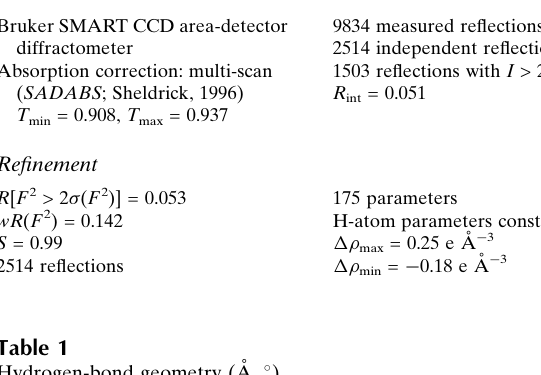
Hydrogen-bond geometry (A˚ , (cid:1)